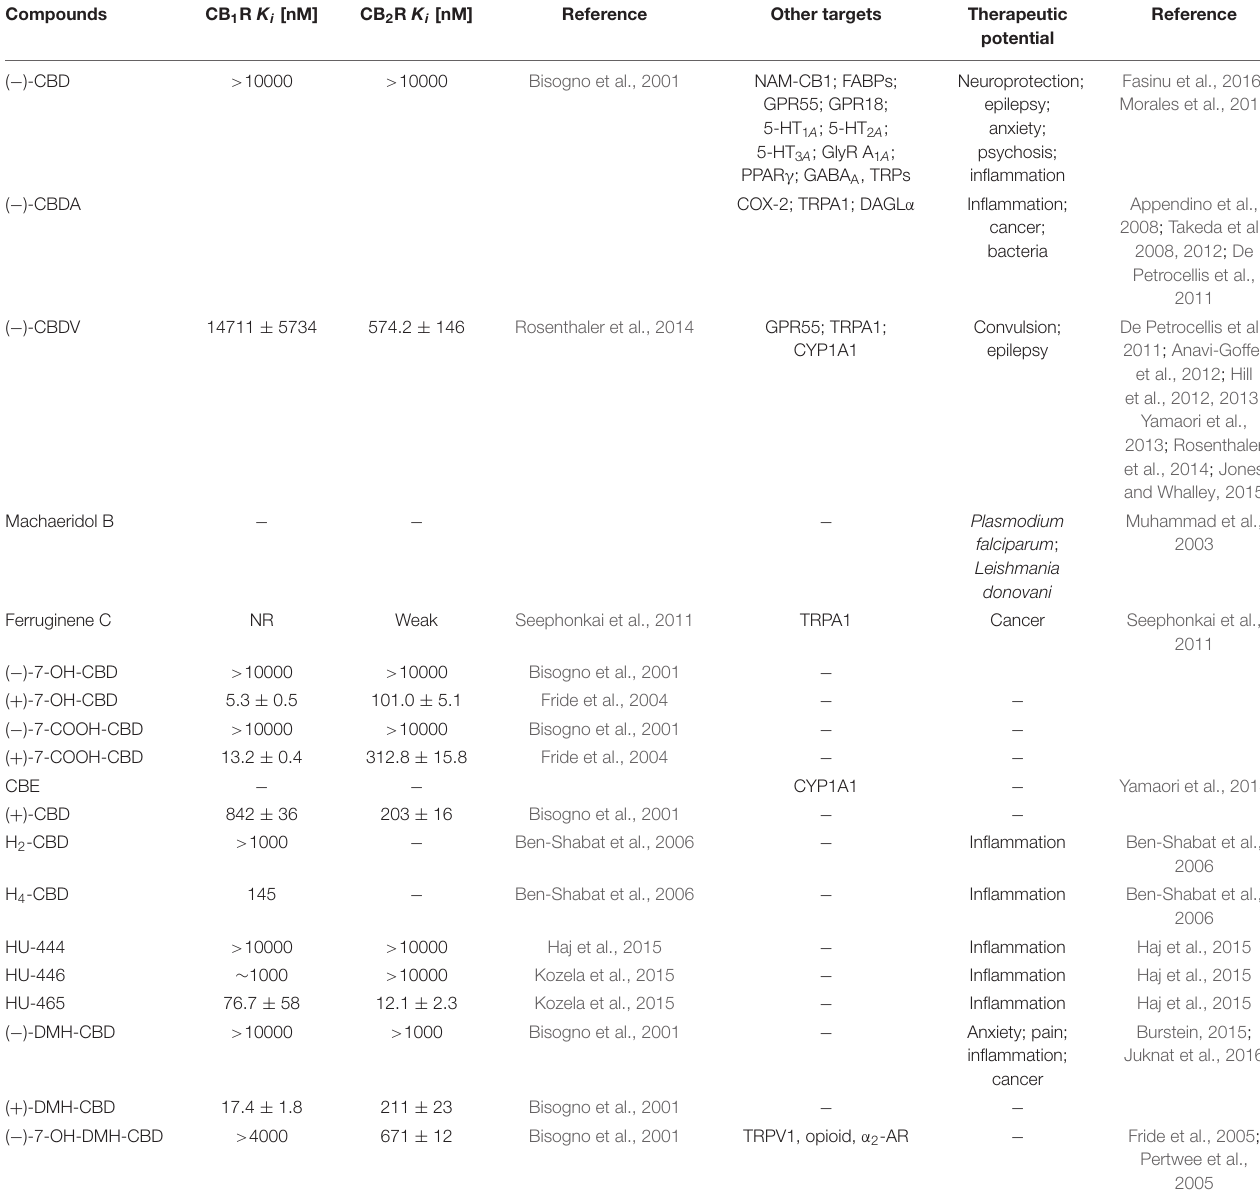
TABLE 1 | CB 1 /CB 2 cannabinoid receptor binding, molecular targets and therapeutic potential of CBD derivatives.